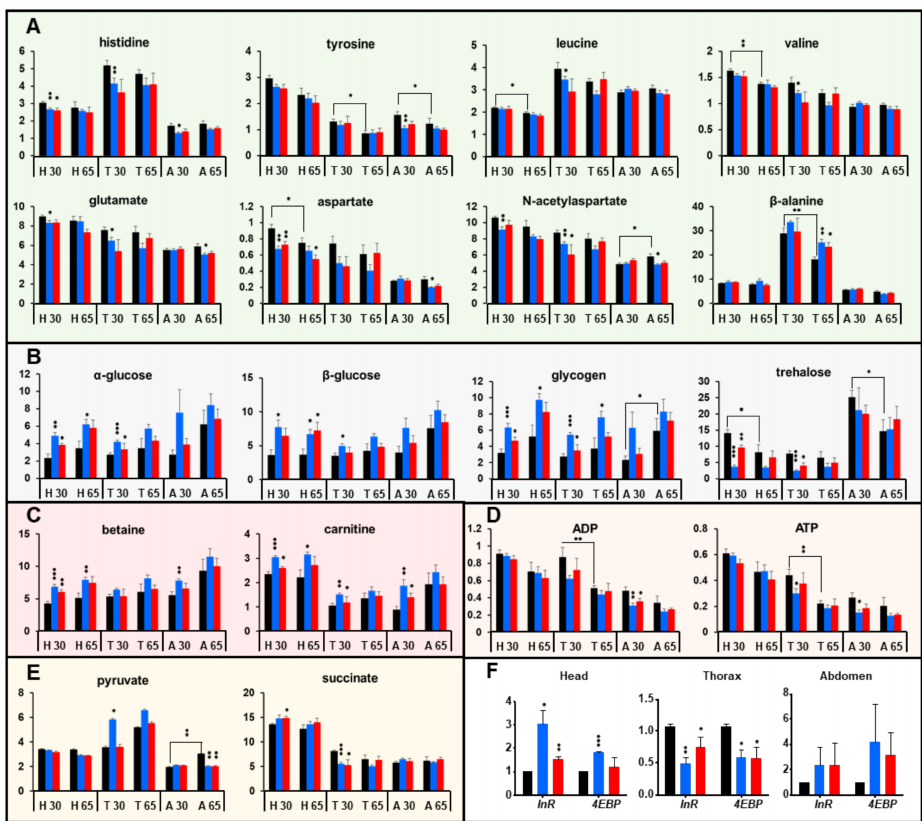
Figure 5. Analysis of metabolites that had significant changes at 30 days by genotype, age and anatomical region. ( A ) Aminoacids. ( B ) Carbohydrates. ( C ) Metabolites related to lipid metabolism. ( D ) Energetic nucleotides. ( E ) Organic acids. ( F ) Relative mRNA levels of the InR and 4EBP genes in head, thorax and abdomen extracts at 30 days. H, T and A refer to the anatomical region; 30 and 65 refer to the age in days. Asterisks over brackets indicate significant differences between young and old control samples; asterisks over colored bars indicate significant differences between KD genotypes and control at that age. In bar diagrams, * p < 0.05, ** p < 0.01; *** p <